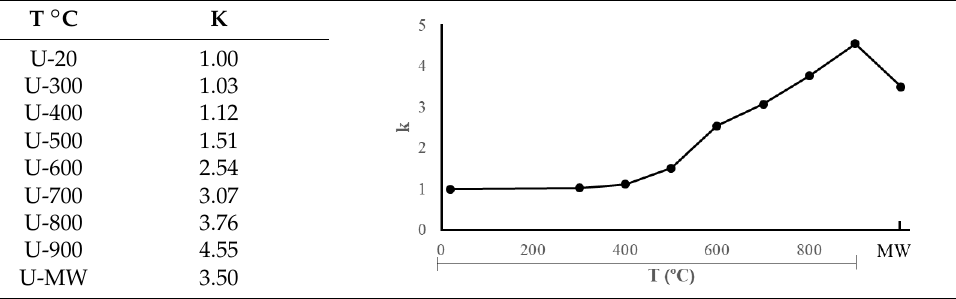
Table 3. The WA content (mg/g) with time of the vermiculite heated at temperatures between 700 ◦ C and 900 ◦ C. Time